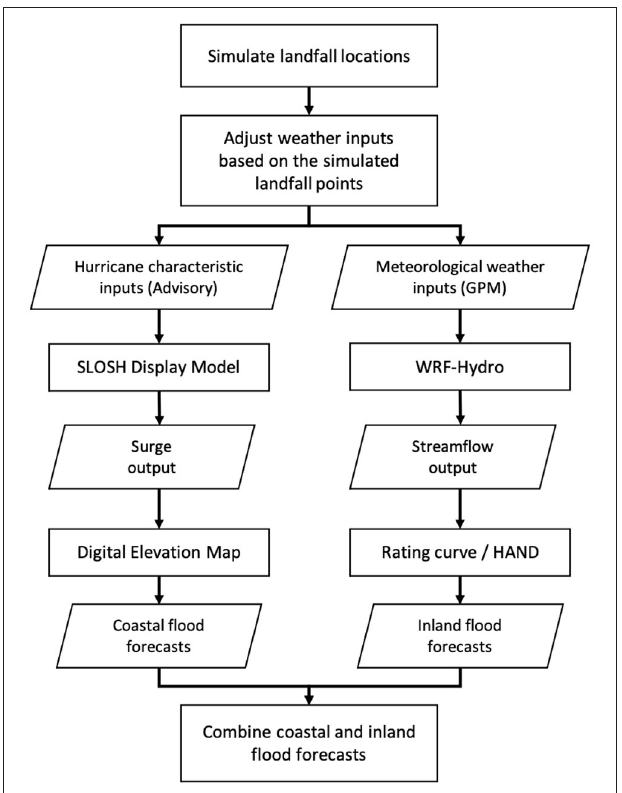
FIGURE 1 | The flow diagram summarizes the overall flood scenario generation methodology which combines both inland and coastal flooding.